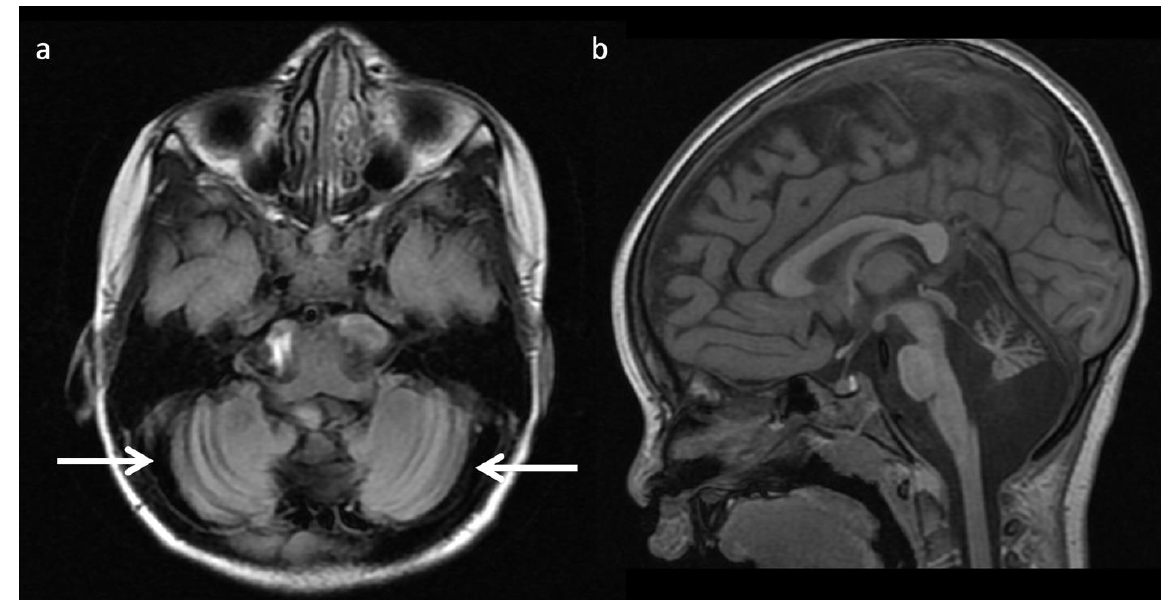
Figure 18. Three year old child with congenital disorder of glycosylation Type 1a (CDG-1a), which is an early-onset neurodegenerative disorder with selective hindbrain involvement. ( a ) Axial T2 FLAIR image of the cerebellum shows diffuse marked cerebellar atrophy and diffuse cerebellar hyperintense T2 signal (white arrow). ( b ) Sagittal T1 image again shows the marked cerebellar atrophy. The pons is also mildly hypoplastic.